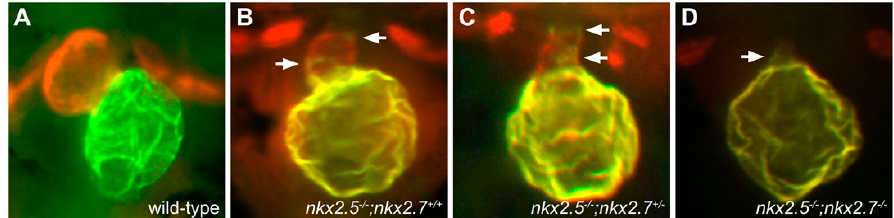
Figure 4. nkx genes are required for maintenance of ventricular cardiomyocyte identity. Compared to the wild-type heart at 52 hpf ( A ), nkx2.5 mutants ( B ) exhibit a reduced ventricle and an enlarged atrium, with ectopic Amhc in some ventricular cells (arrows), and additional loss of a single allele of nkx2.7 ( C ) leads to increased presence of ectopic Amhc in the ventricle (arrows). nkx2.5;nkx2.7 double homozygotes ( D ) exhibit only a small ventricular remnant, with Amhc present throughout (arrow). Red fluorescence labels sarcomeric myosin heavy chain, and green fluorescence indicates localization of Amhc. Images adapted from [29].